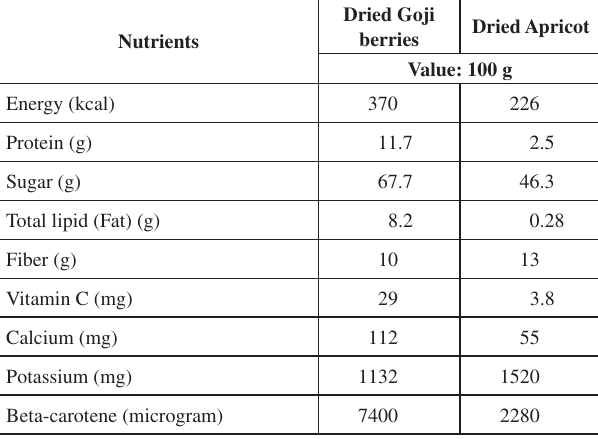
Table 1. Nutrient data for dried goji berries compared with dried apricots (Source: Paul M. Gross, 2006. Tables Ciqual (AFFSA)) Nutrients